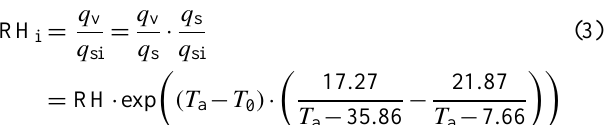
the instantaneous winds from a 18-km resolution model with the hourly averaged point observations. Nevertheless, Fig. 4 shows that the model wind follows the evolution of the ob- served 10-m wind quite well although the correlation coeffi- cient is only 0.71. The mean wind speed of about 6 m s − 1